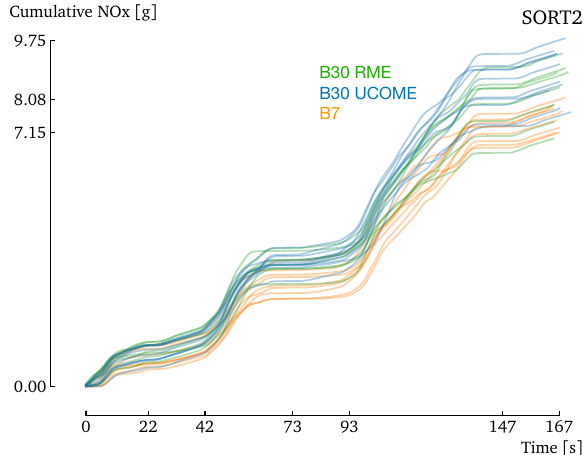
Figure 9. The cumulative NOx emissions along the SORT 2 test runs indicate, alike for SORT 1, an increase in NOx emissions for B30 RME and B30 UCOME compared to